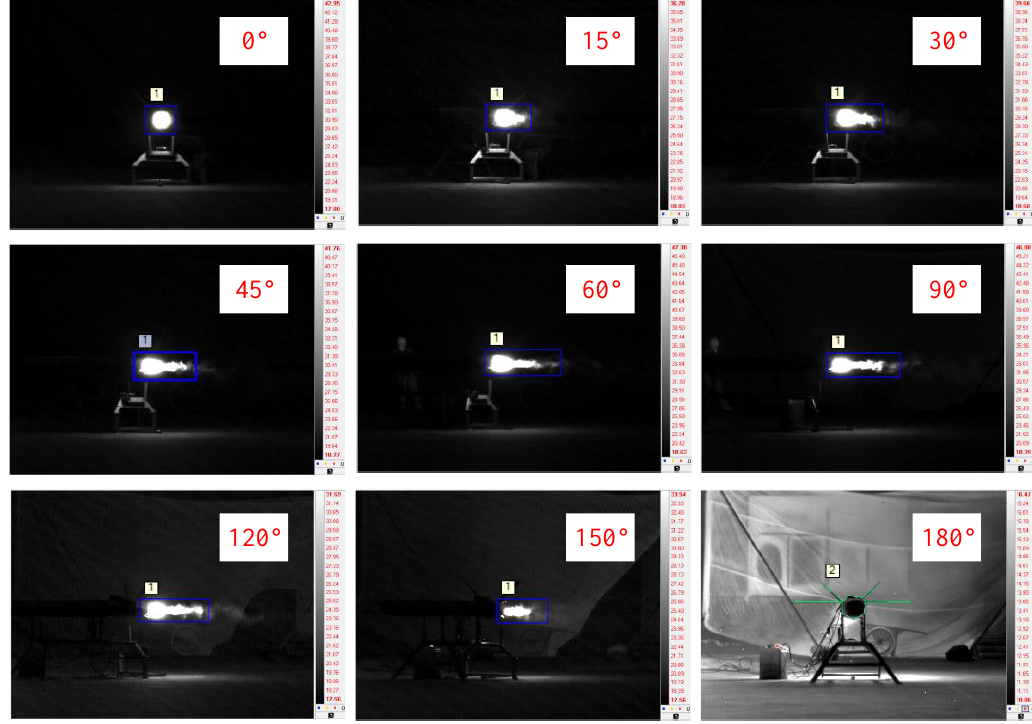
Figure 14. UAV images captured by the MWIR camera at different observation angles.